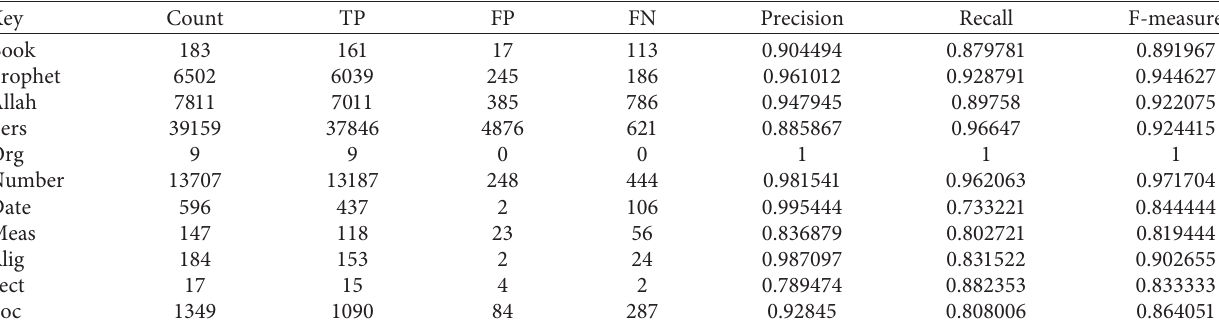
Figure 10: Results of not using blacklist. Table 16: Overall results for